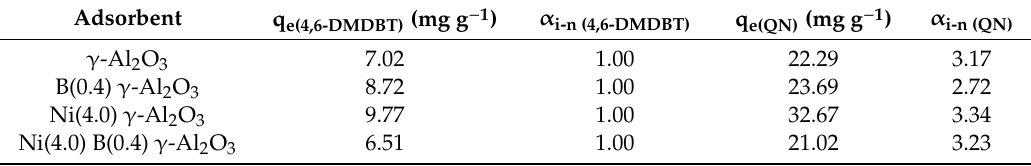
Table 2. Experimental adsorption capacity and selectivity for 4,6-DMDBT and